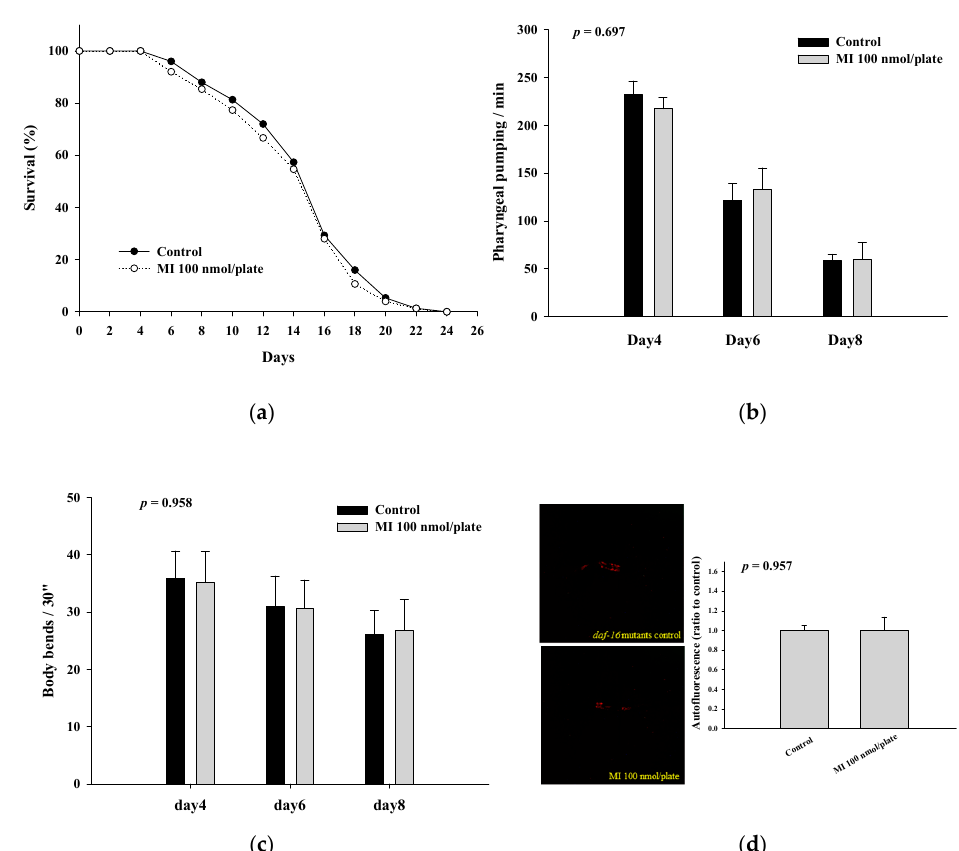
Figure 4. Effects of the myo-inositol (MI) on the lifespan and health of the DAF-16 mutants. ( a ) For the lifespan assay, various mutants (90 worms per group) were grown on plates containing with or without 100 nmol/plate of MI. The surviving worms were counted every two days. The surviving percentages were obtained, and the results were analyzed by the log-rank test with the SPSS software. For the health analysis, the nematodes were grown on plates containing with or without 100 nmol/plate of MI. ( b ) The pharyngeal pumping ( n = 10), ( c ) body bends ( n = 10), and ( d ) autofluorescence (left: photos; right: quantitative results, n = 3) were determined as described previously. Values are presented as mean ± SD, and p values are shown in the figures. The results are from a representative experiment out of three independent